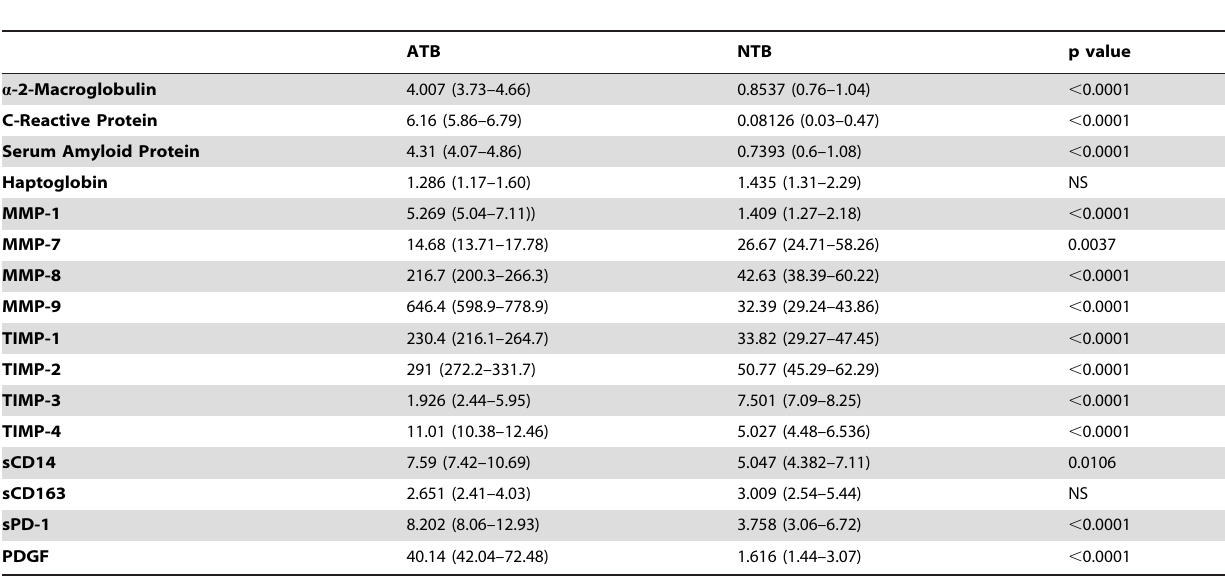
Table 2. Systemic levels of immune parameters in active TB and TB uninfected